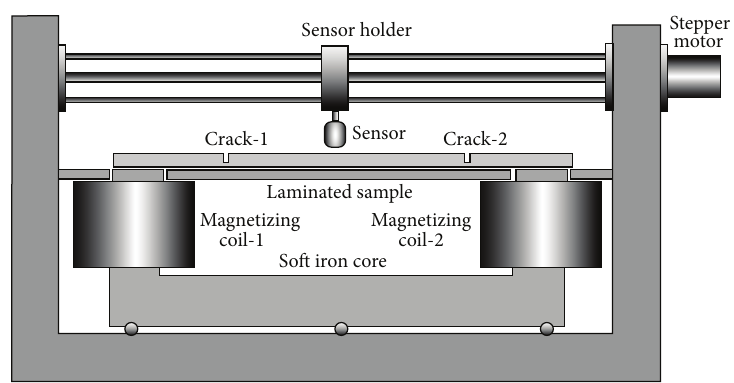
Figure 4: Schematic diagram of the magnetic flux leakage measurement